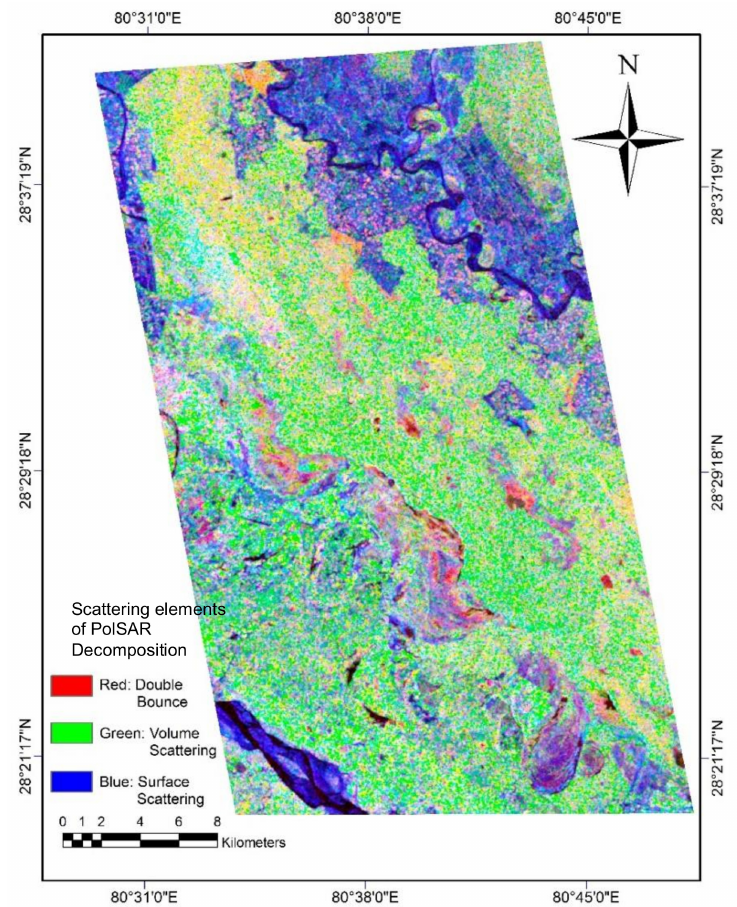
Figure 8. False-color composite of the scattering elements of the ALOS PALSAR